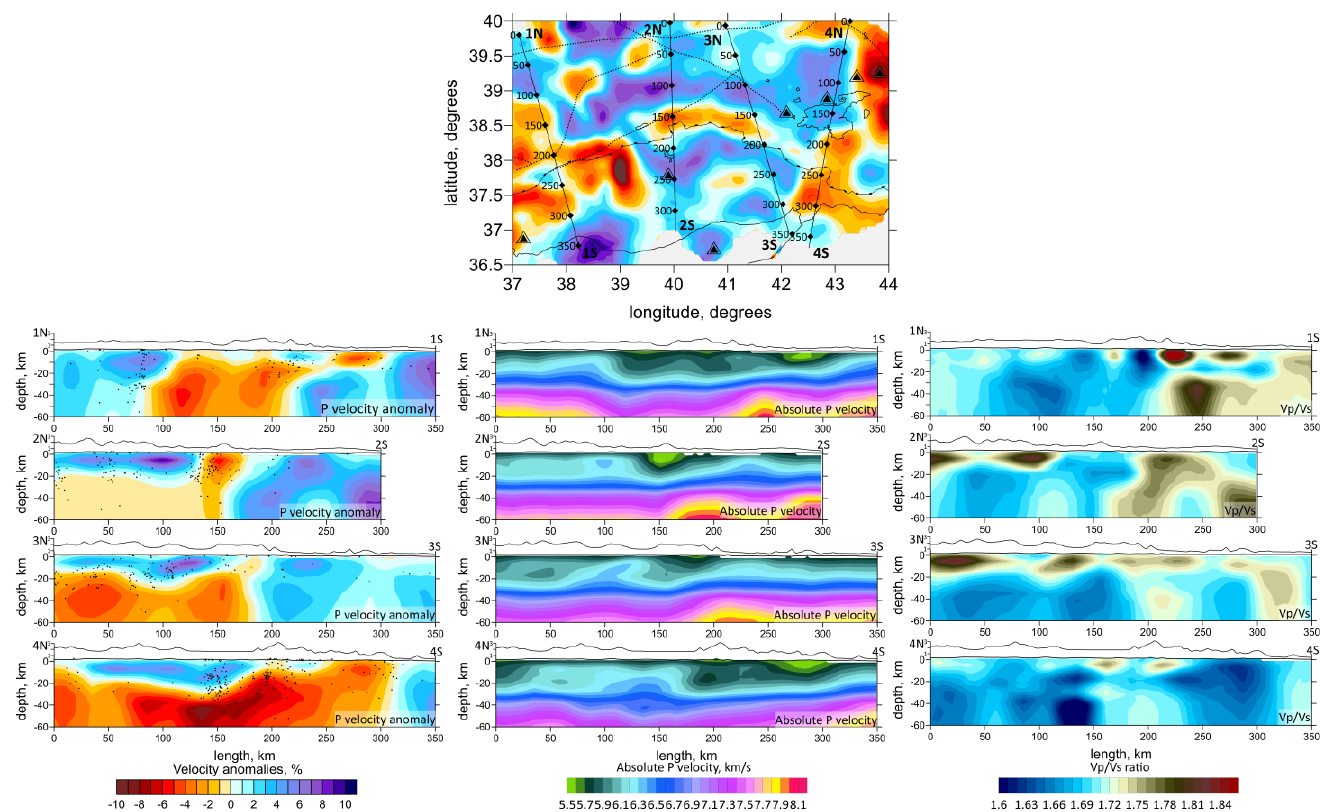
Figure 4. P-velocity anomalies in vertical sections (at left), absolute P-velocities (in the middle), the Vp/Vs ratio (at right). Horizontal section 10 km with main geological structure elements and profiles locations on the top.